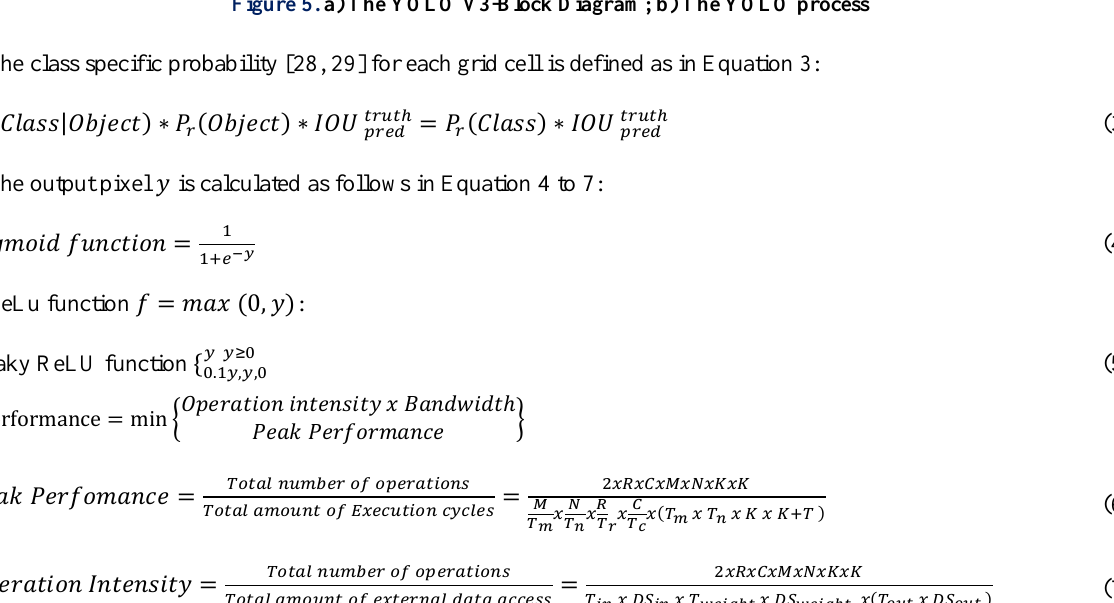
Figure 5. a) The YOLO V3-Block Diagram; b) The YOLO